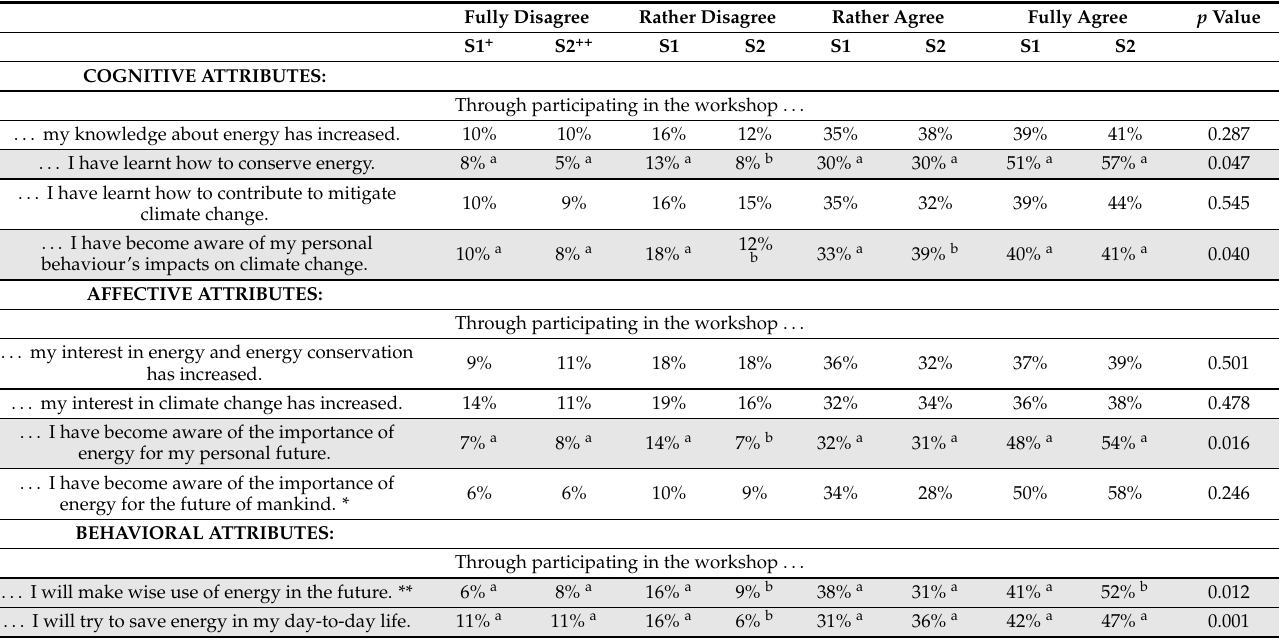
Table 1. Students’ self-reporting about the potential future impacts of participating in an ETSIT workshop (rounded percentage) directly after (up to two days after) and approximately one year after the workshop. Fully Disagree Rather Disagree Rather Agree Fully Agree p Value S1 + S2 ++ S1 S2 S1 S2